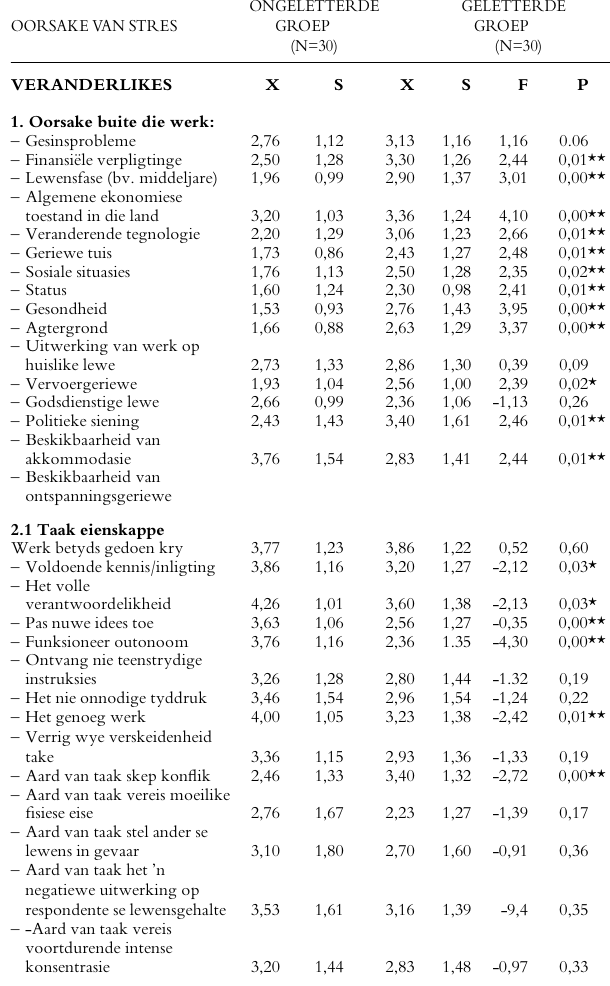
TABLE 4 *OORSAKEVANSTRES (GEDETAILLEERDE INLIGTING)